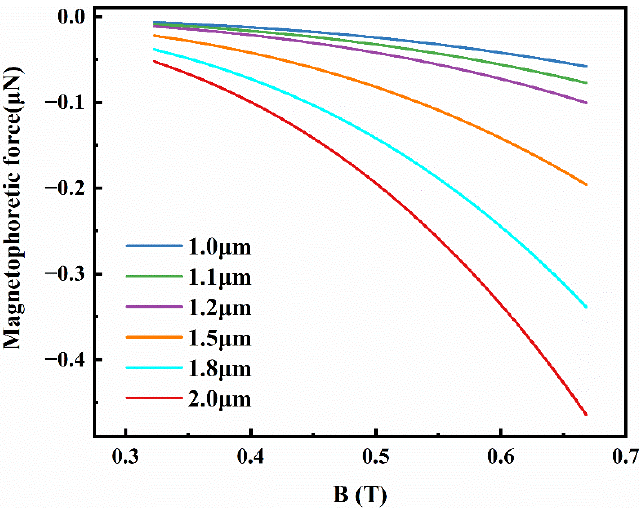
Figure 7. Magnetophoretic force of different particle sizes acting on diverse magnetic field intensity.